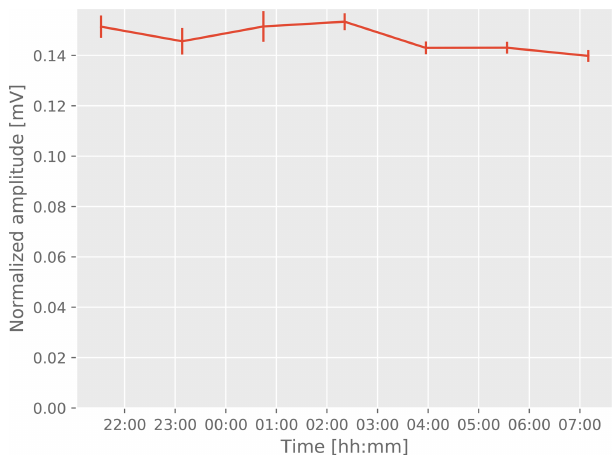
Figure 7. Measured amplitude for repeated measurements within series 11, 27kHz (24